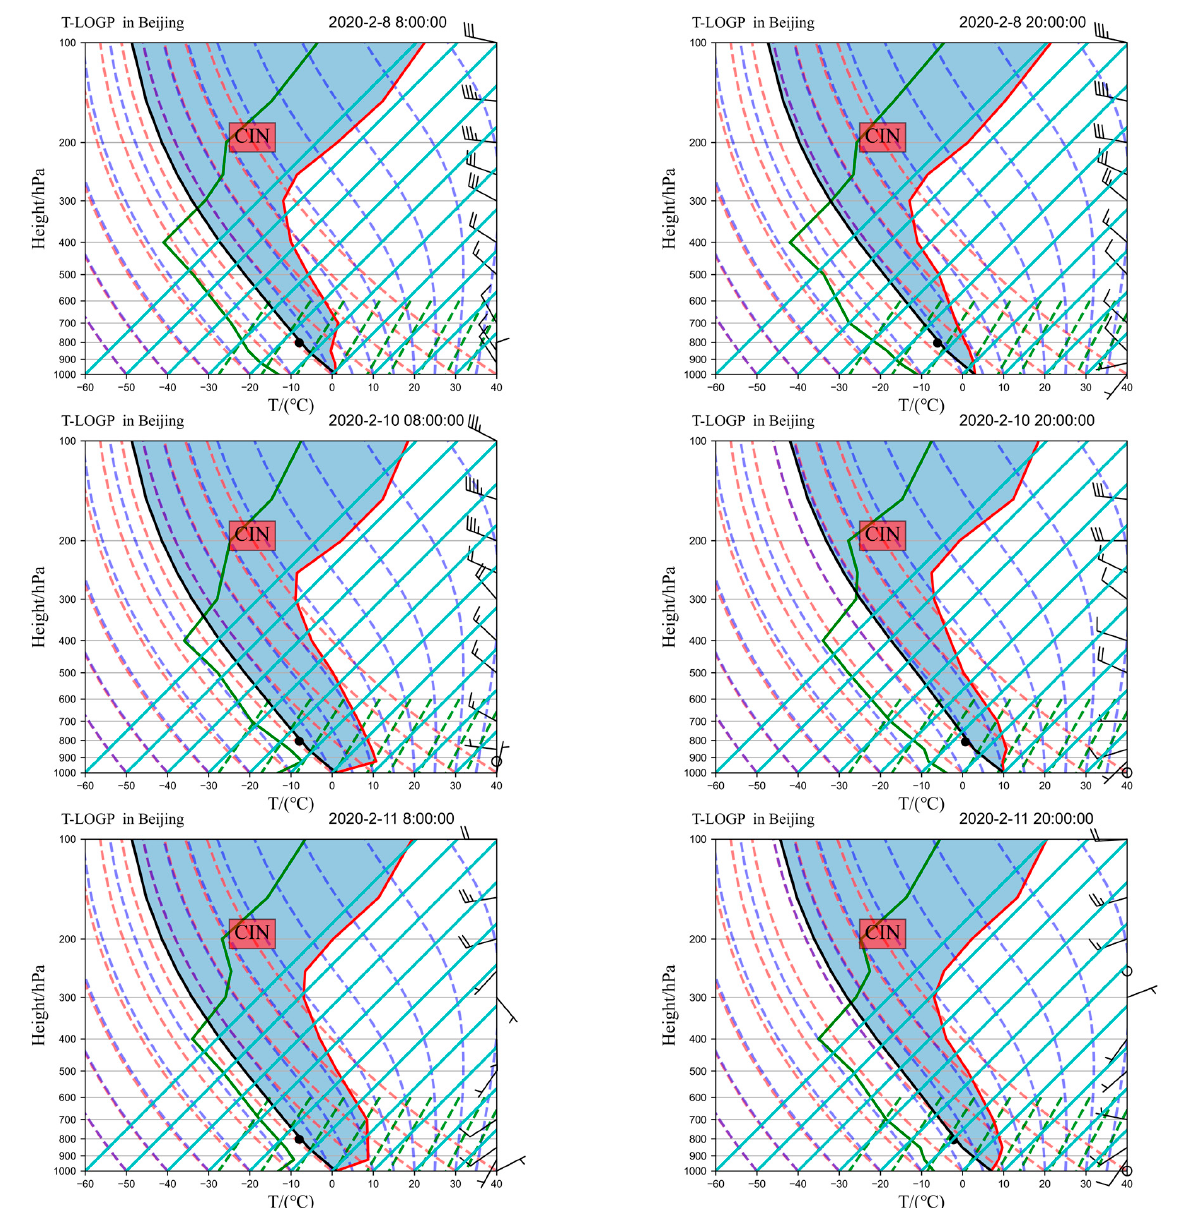
Figure 5. Temperature (T)–pressure (lnP) plots in urban Beijing at 08:00 and 20:00 on 8, 10 and 11 February 2020. The solid gray line shows the isobaric pressure line, the solid cyan line is the isothermal line, the solid green line is the vertical profile of ambient temperature, the solid red line is the vertical profile of ambient dew point, the solid black line is the adiabatic lift path of the gas mass, the dashed red line is the dry adiabatic line, the dashed blue line is the wet adiabatic line, and the dashed cyan line is the isosaturated specific humidity line.